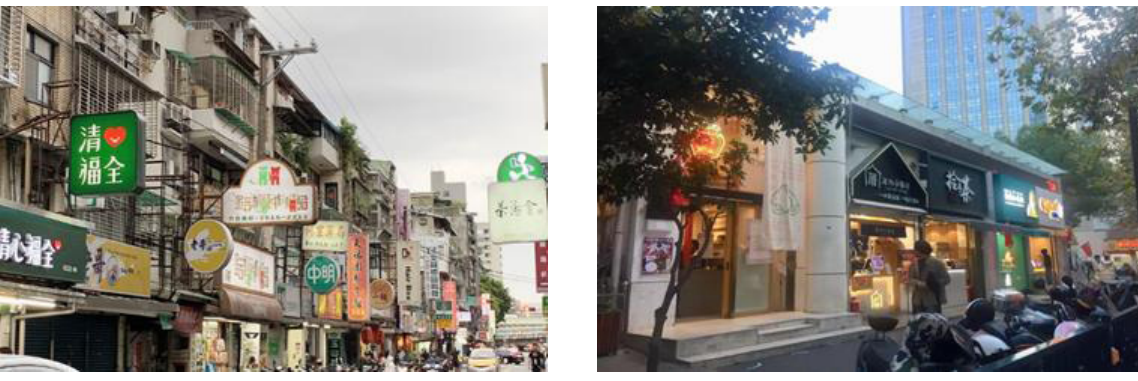
Note: Pictures were collected by Tsai (2019) and the research team on August, 2019. Figure 1. The BTSs on Chinese urban streets such as Taipei of Taiwan (left side) and Nanjing of Mainland China (right